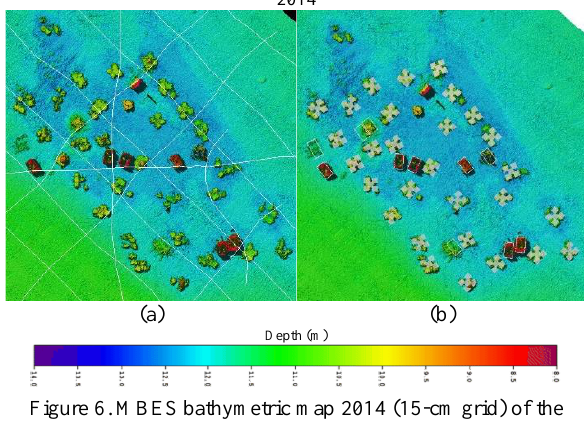
Figure 6. MBES bathymetric map 2014 (15-cm grid) of the Senigallia AR superimposing ship tracks during the survey (a) and 3D rendering of the original AR structures (b) Difference surface were calculated between the surveyed data to make additional volume and depth assessments over monitoring years.